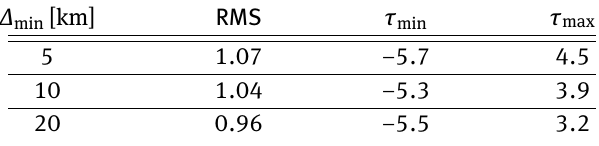
Figure 2: The empirical variogram (NMA2013v30) is shown for the Hordaland location (2) of Fig. 1, together with a fit (solid line). The variogram’s expected dispersion is marked by dashed lines.